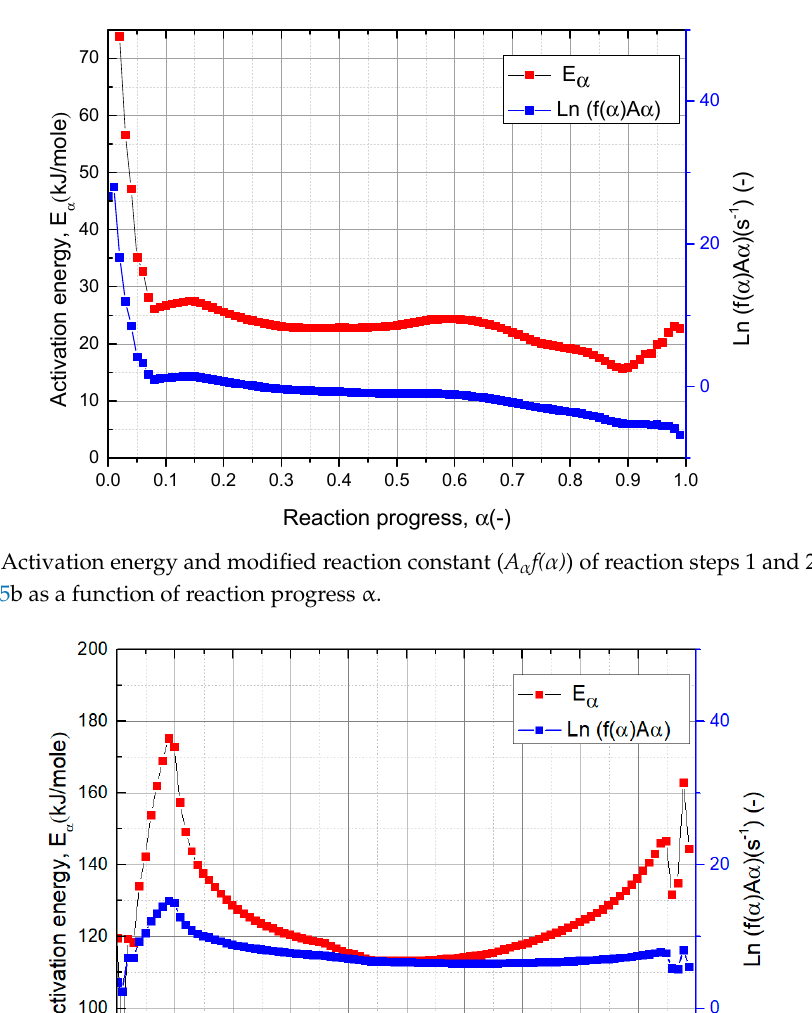
Figure 8. Kinetic prediction activation energy and modified reaction constant (A α f( α )) of reaction step 3 as a function of reaction progress α .